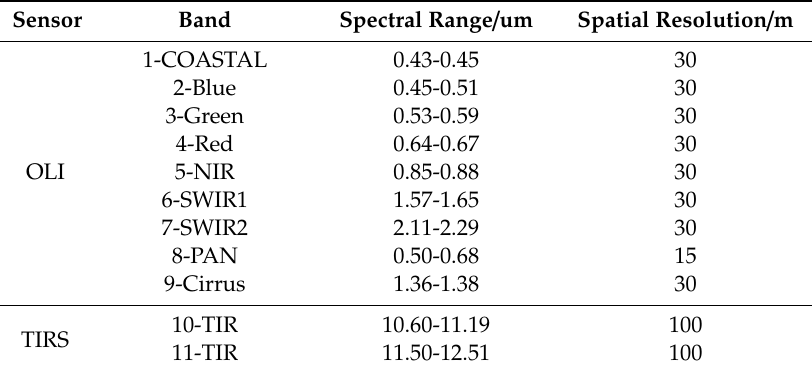
Table 3. The parameters of Landsat 8.